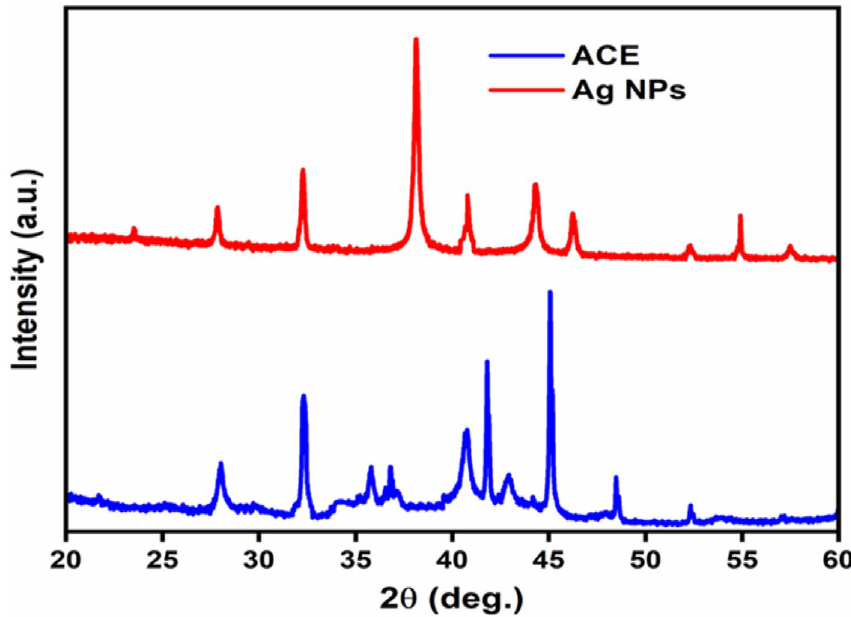
Figure 5. X-ray diffraction (XRD) of ACE and Ag. NPs of Plantago lanceolata